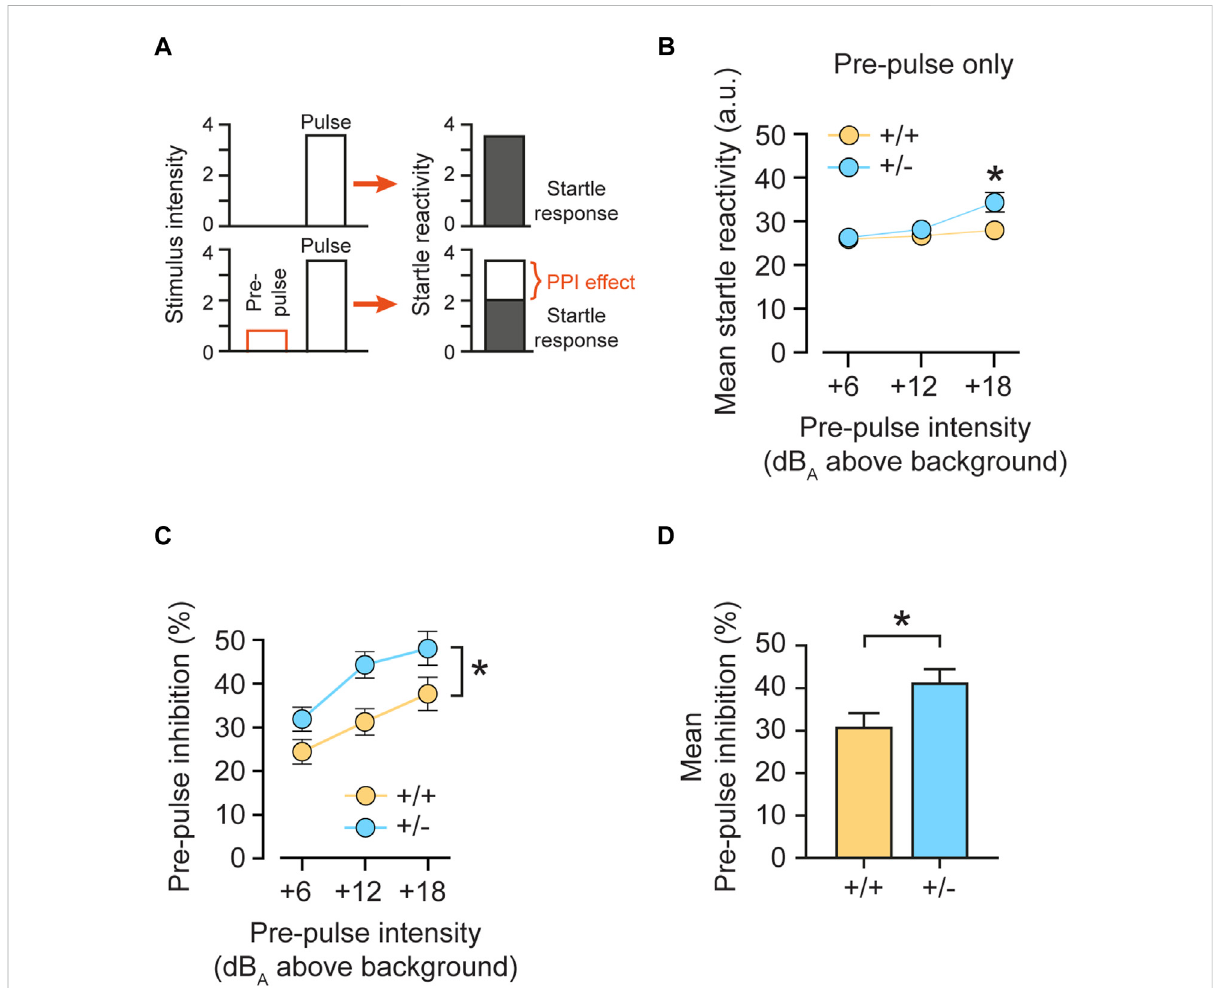
Monoallelic loss of rdx increases pre-pulse inhibition. (A) Schematic presentation of the pre-pulse inhibition (PPI) effect. A low pre-pulse (stimulus intensity) reduces the response to the subsequent startle-eliciting pulse. (B) Mean startle reactivity obtained on pre-pulse-alone trials as a function of pre-pulse intensity (dB A above background noise level of 65 dB A ). (C) Pre-pulse inhibition (PPI) expressed as percent inhibition (percent startlereductionrelativetopulse-alonetrials)plottedasafunctionofpre-pulseintensities(dB A abovethebackgroundnoiselevelof65dB A ). (D) Mean PPI as percent of inhibition across pre-pulse intensities illustrated in (C) . Heterozygous (+/-) rdx knockout mice are characterized by higher pre-pulse inhibition, compared to wildtype (+/+) littermate controls. Data were obtained from n = 16 (+/+), 16 (+/-) and 16 ( − / − ) adult rdx knockout animals. Equal numbers of males and females were used for each genotype. Repeated measurement ANOVA was used to assess statistical signi fi cance. * p < 0.05. Data represent mean ±